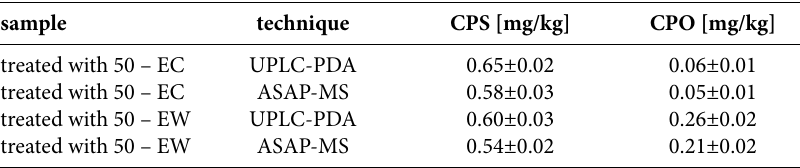
Table 1 . Comparison between results from UPLC-PDA and from ASAP-MS in the analysis of two apple samples.